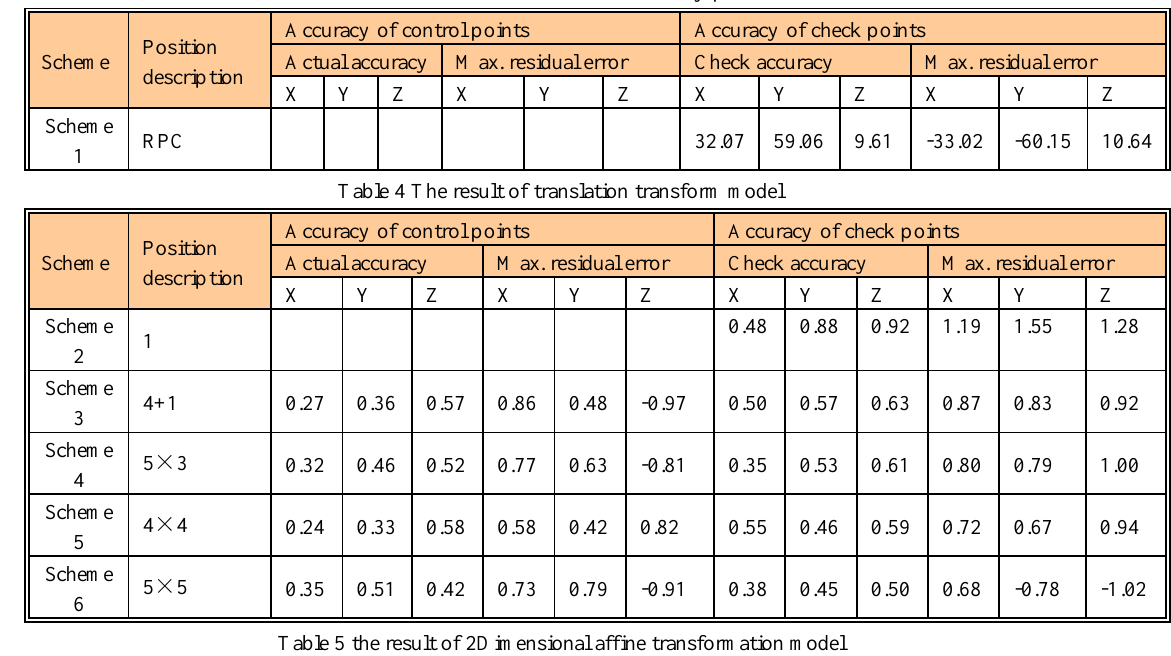
Table 3 The result of RPC model directly position